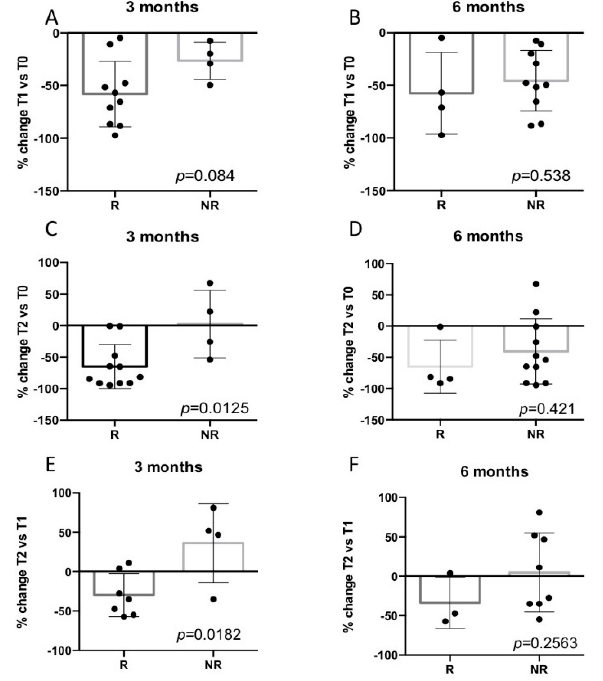
Figure 4. Percent (%) change in GIN values between T2 and T0 and T2 and TA are associated with a 3 ‐ month clinical response. Scatter box plots of the % change in GIN in responding patients (R) compared with nonresponding patients (NR). Clinical response at 3 months: ( A ) T1 vs. T0, ( C ) T2 vs. T0 and ( E ) T2 vs. T1. Clinical response at 6 months: ( B ) T1 vs. T0, ( D ) T2 vs. T0 and ( F ) T2 vs. T1. The error bars reflect the standard deviations.